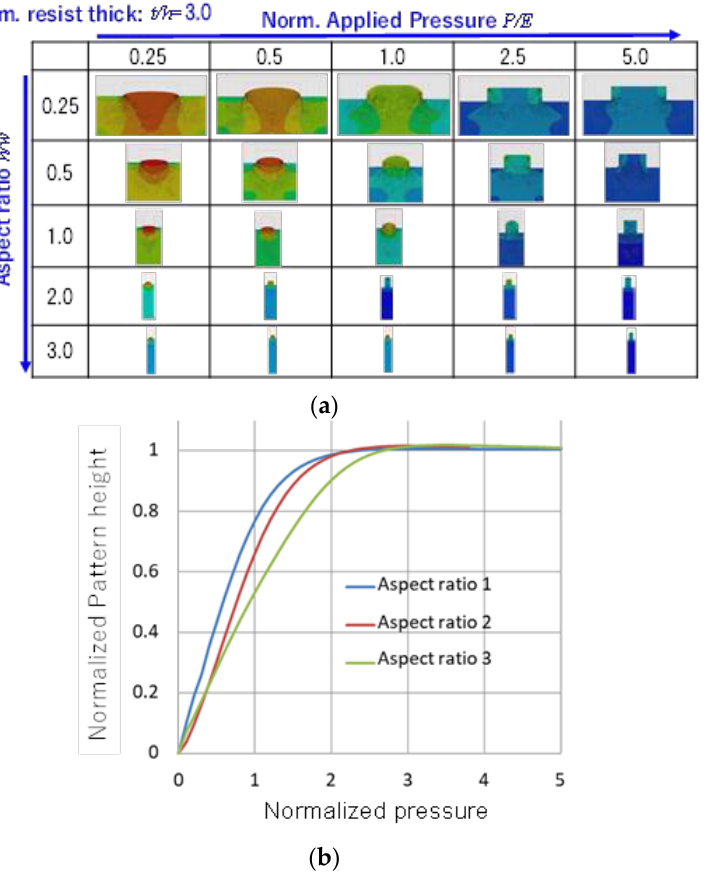
Figure 6. Learning data by numerical simulation for a compliment of pressure and geometrical structural dependence. ( a ) Simulation results for learning data; and ( b ) Prediction results of the pattern height after nanoimprinting for mold patterns with various aspect ratios, varying with applied pressure using deep learning.